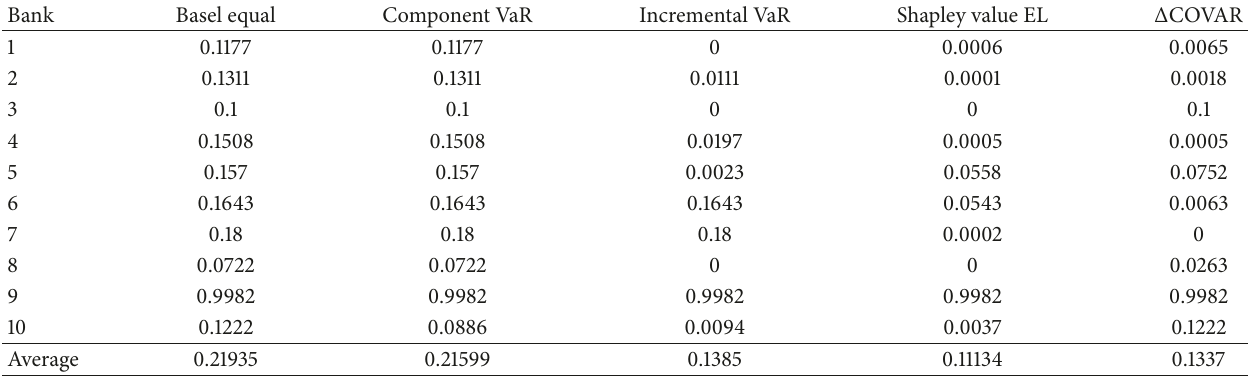
Table 4: Individual bank default probabilities under the macroprudential capital requirements in